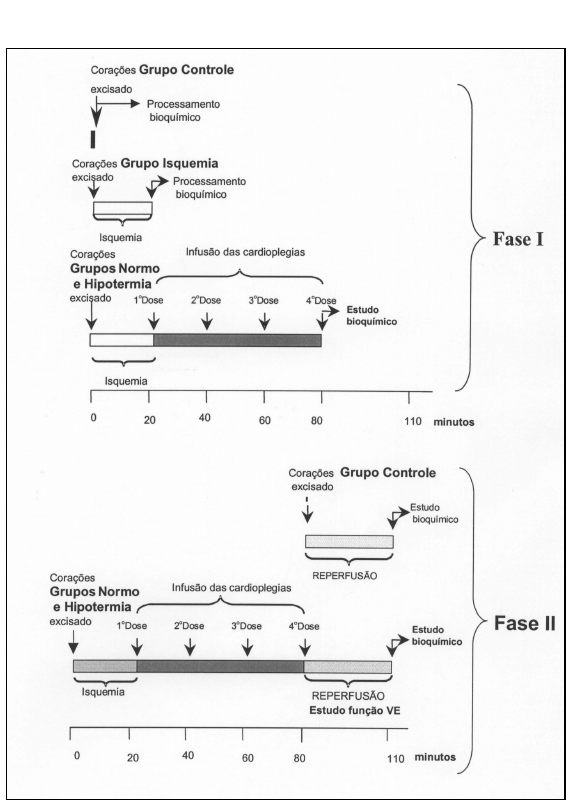
Fig. 1 - Representação esquemática do protocolo experimental, evi- denciando-se os passos da